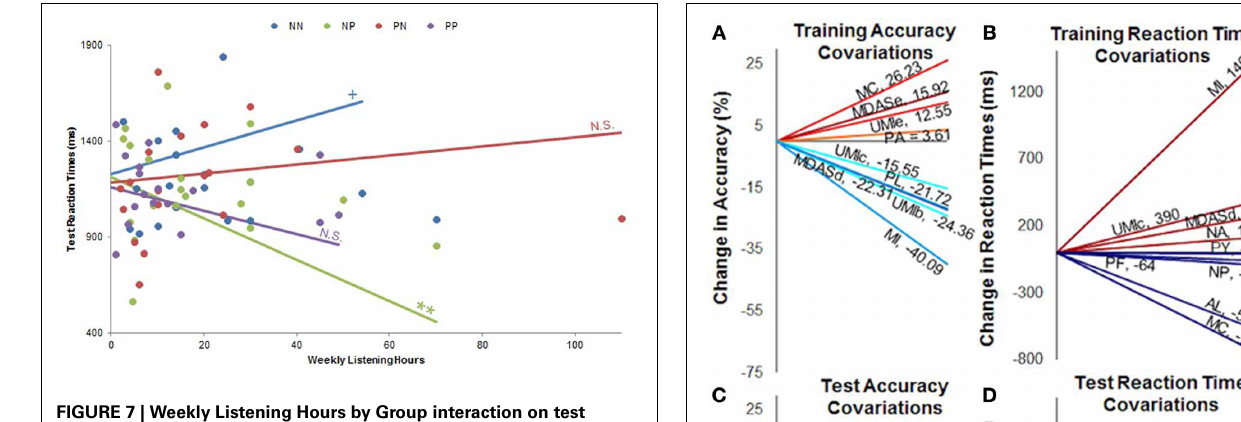
FIGURE 7 | Weekly Listening Hours by Group interaction on test reaction times. There was a significant Weekly Listening Hours by Group interaction on test reaction times ( p < 0 . 0001). Subjects who listened to music more frequently responded faster when they trained with neutral music and tested with pleasurable music (NP; p < 0 . 01). There was also a trend correlation such that these subjects responded slower when they listened to neutral music during both training and testing (NN, p = 0 . 08). No other within-group correlations were significant (all p s > 0 . 37). PN: subjects who listened to pleasurable music during training and neutral music during testing; PP: subjects who listened to pleasurable music during both training